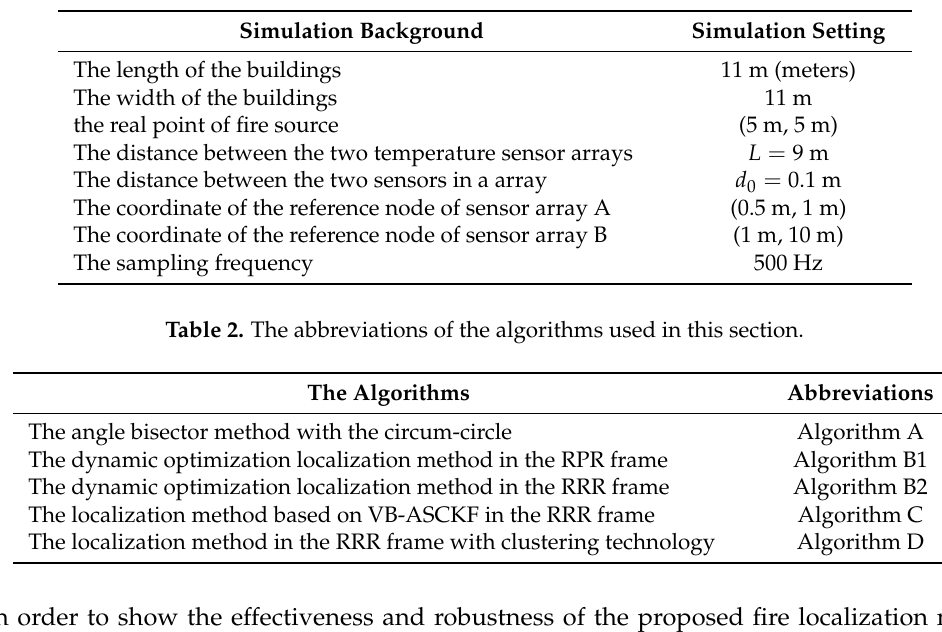
Table 1. The simulation settings.